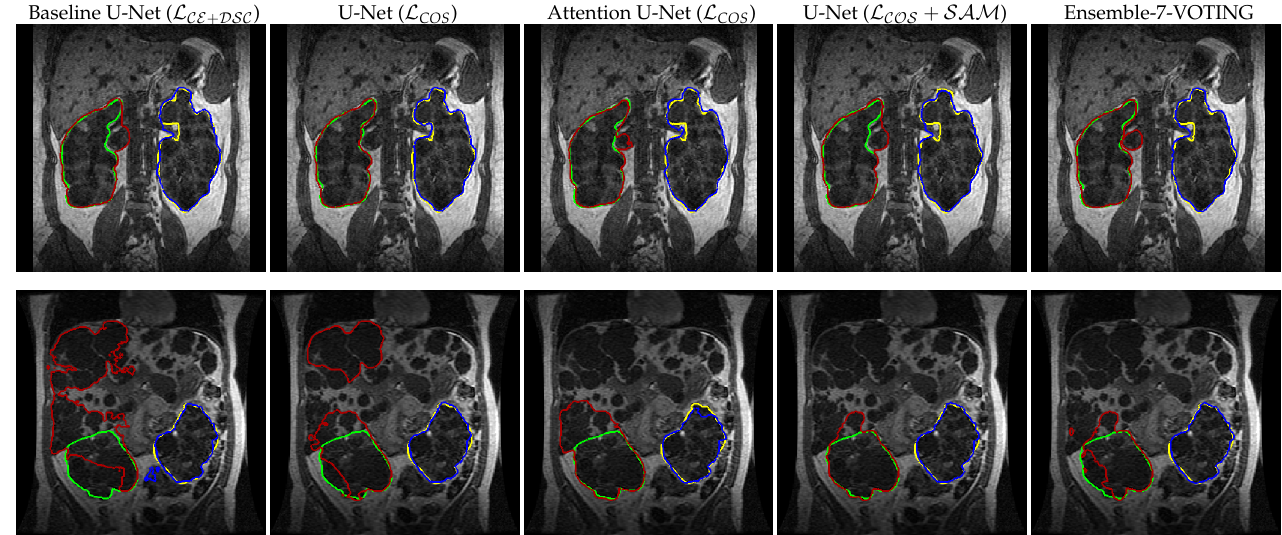
Figure 5. Qualitative results after post-processing (128 x 128): random slices of the best (top row) and the worst case segmentation (bottom row) from the baseline U-Net ( L CE + DSC ) compared to its corresponding U-Net ( L COS & L COS + SAM ), Attention U-Net ( L CE + DSC ), and Ensemble-7- VOTING predictions. The best case has stage 1 CKD, while, the worst case has stage 2 CKD. The ground truth segmentation is colored in green and yellow, while the network segmentations are colored in red and blue. Top row DSC (left to right): Baseline U-Net = 0.963, U-Net ( L COS ) = 0.965, Attention U-Net ( L CE + DSC ) = 0.965, U-Net ( L COS + SAM ) = 0.962 and Ensemble-7-VOTING = 0.969. Bottom row DSC: Baseline U-Net = 0.606, U-Net ( L COS ) = 0.713, Attention U-Net ( L CE + DSC ) = 0.747, U-Net ( L COS + SAM ) = 0.784 and Ensemble-7-VOTING = 0.780. There is no significant